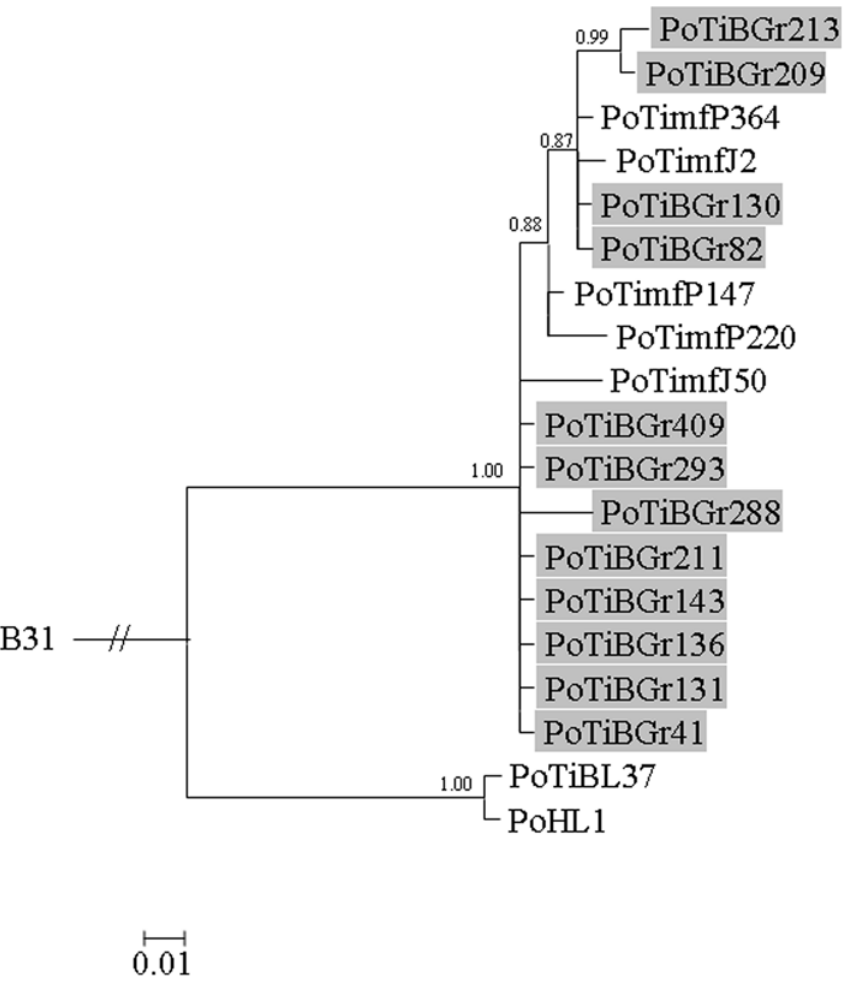
Figure 3. Bayesian phylogenetic tree of B.lusitaniae strains based on ospA . The tree was rooted with B. burgdorferi strain B31. Posterior probabilities values are indicated to provide branch support. The scale bar represents 1% sequence divergence. B. lusitaniae samples derived from Graˆndola are highlighted.